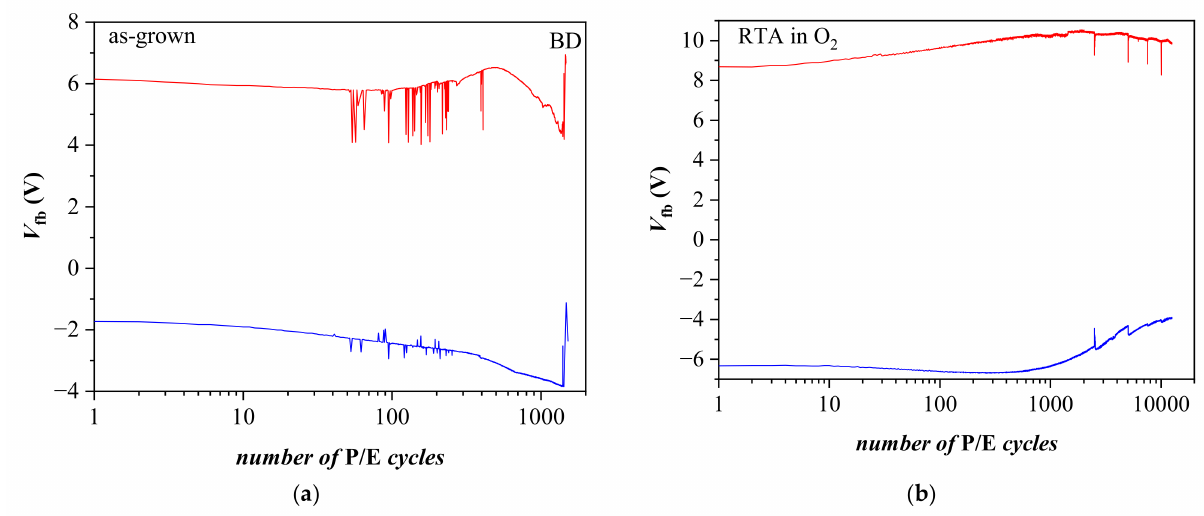
Figure 6. Endurance of BO /5 × (20:5)/TO (3.5 nm SiO 2 ) capacitors before ( a ) and after O 2 annealing ( b ) measured under voltage pulses +/ − 25 V. Red lines correspond to V p = 25 V, blue ones to V p = − 25